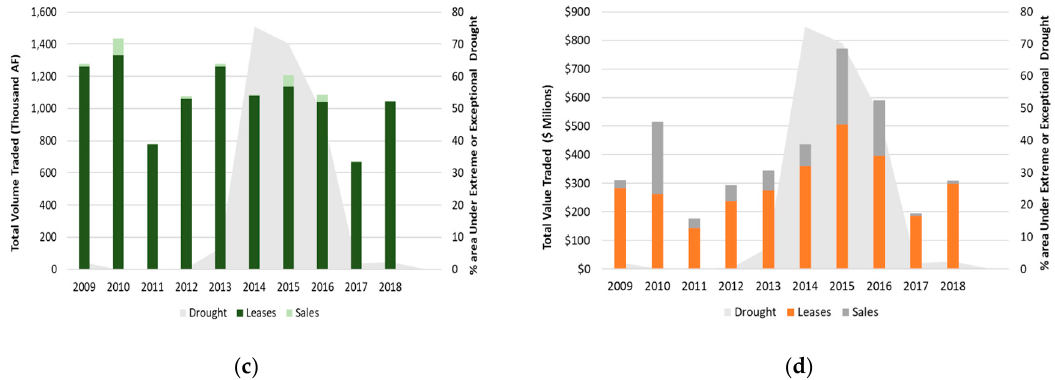
Figure 3. ( a ) Water supply by source, ( b ) water demand by sector, ( c ) total volume traded, and ( d ) total value traded in California. Source: Authors’ calculations, California Water Plan updates [26], and WestWater Research. Drought data are from the US drought monitor [27]. All prices are in real 2009$ using the CPI—All Urban Consumers Average from the BLS.